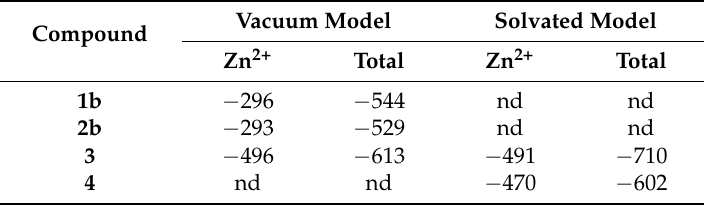
Table 1. Interaction energies in